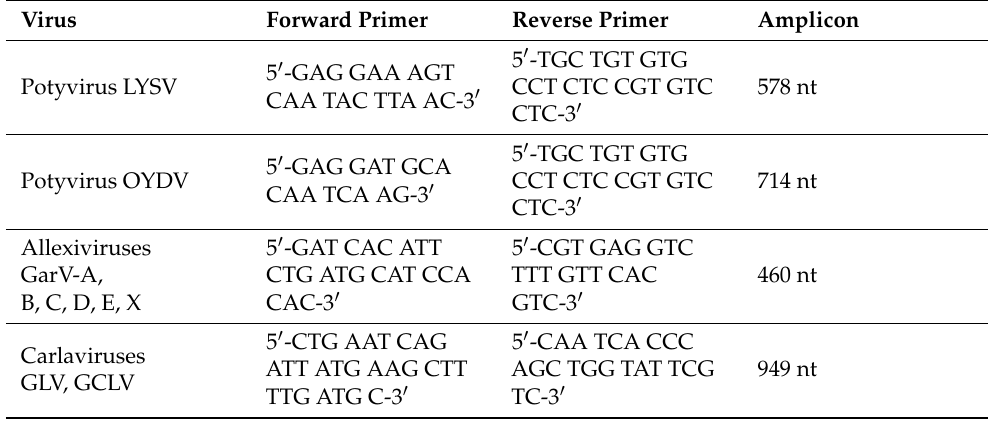
Table 1. The specific primers for garlic